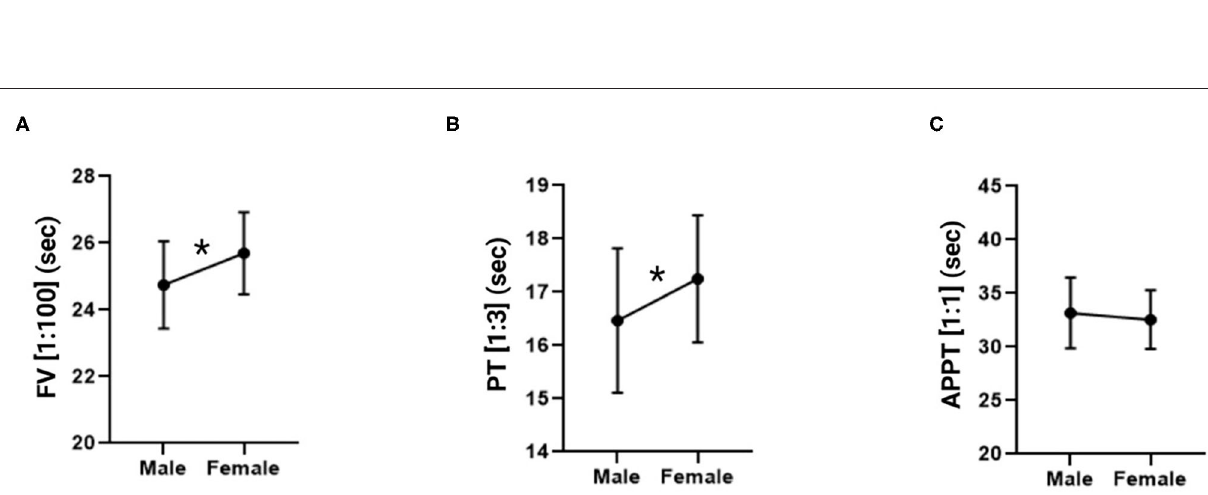
FIGURE 3 | Factor V, prothrombin time and activated partial thromboplastin time measurements in male and female mice. (A) Factor V in a 1:100 dilution. (B) Prothrombin time in a 1:3 dilution. (C) Activated partial thromboplastin time in a 1:1 dilution. The data is expressed as mean ± standard deviation. * p < 0.05 in Student’s t-